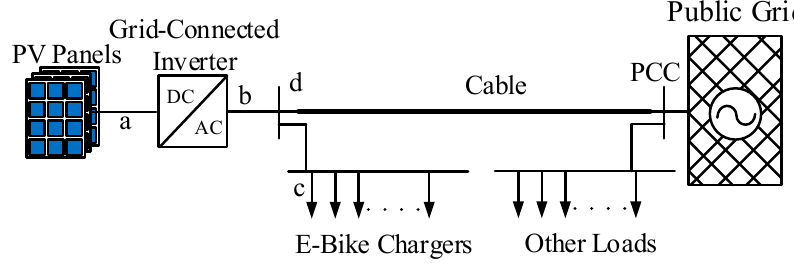
Figure 2. The single-line diagram of the PV Charging Station.